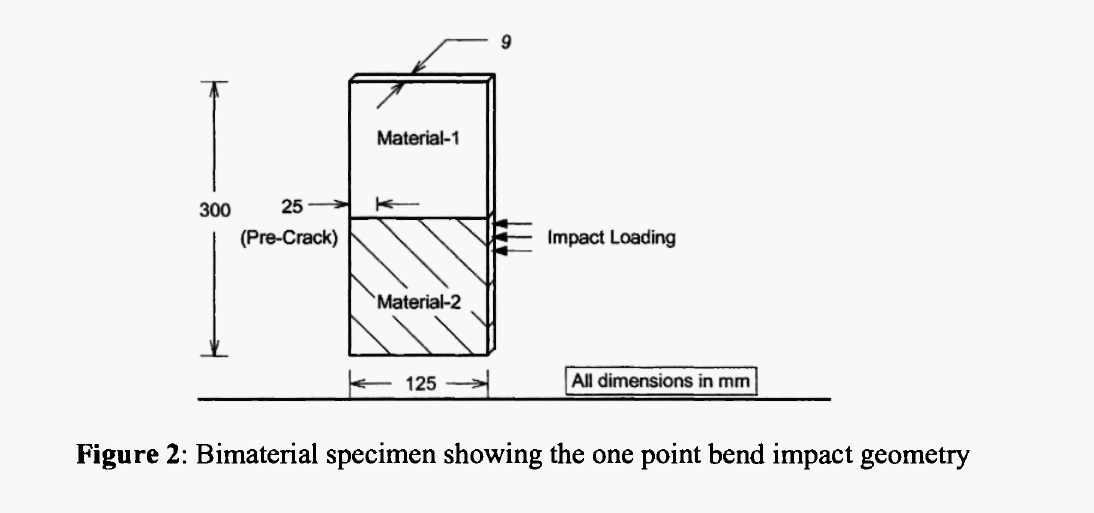
Figure 2: Bimaterial specimen showing the one point bend impact